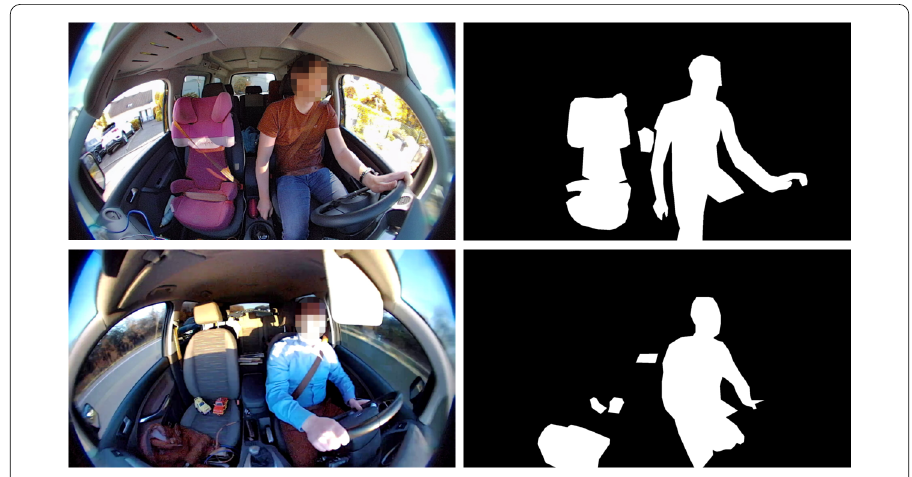
Figure 1 Left: An RGB image of the test set. Right: The corresponding binary segmentation mask by which the foreground instances are separated of the